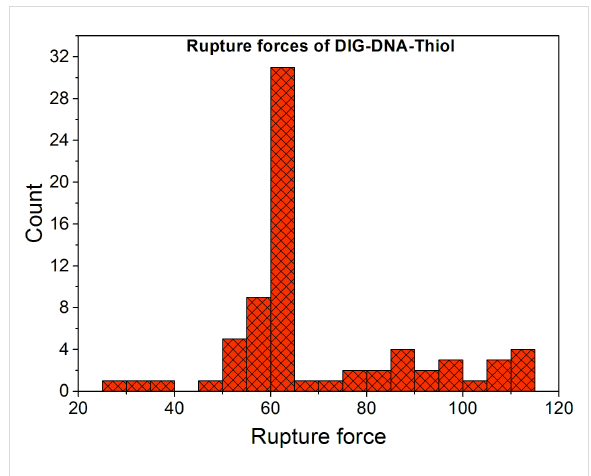
Figure 5: Optical force measurements of DIG-DNA-Thiol. Distribution of rupture forces for DIG-DNA-Thiol pulled versus anti-DIG beads (72 measurements, bin size 5). The average rupture force is around 60 pN with maximum forces reaching up to 115 pN. Pulling speed 100